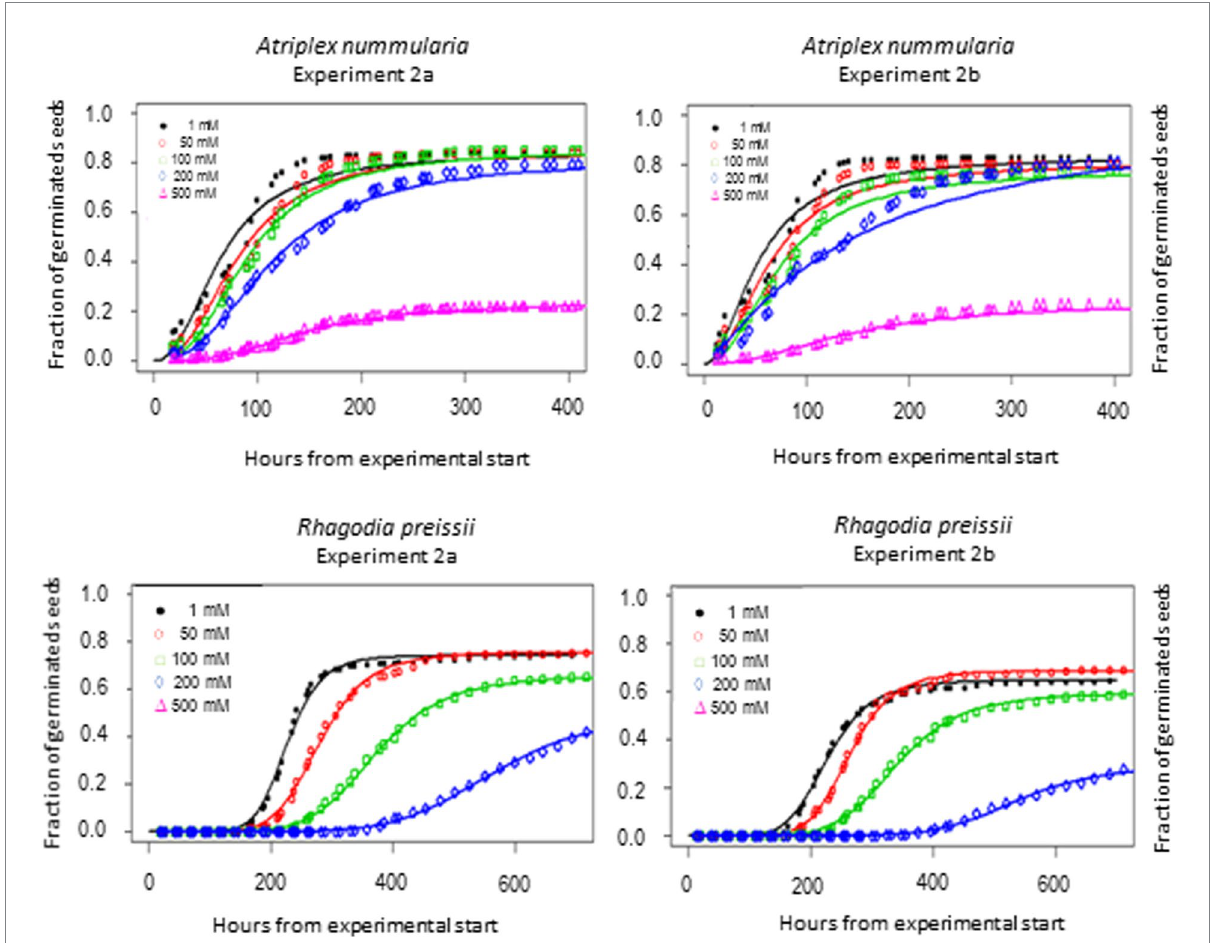
FIGURE 4 Germination curves for A. nummularia and R. preissii at five different salinity levels. No seeds of R. preissii germinated at the 500